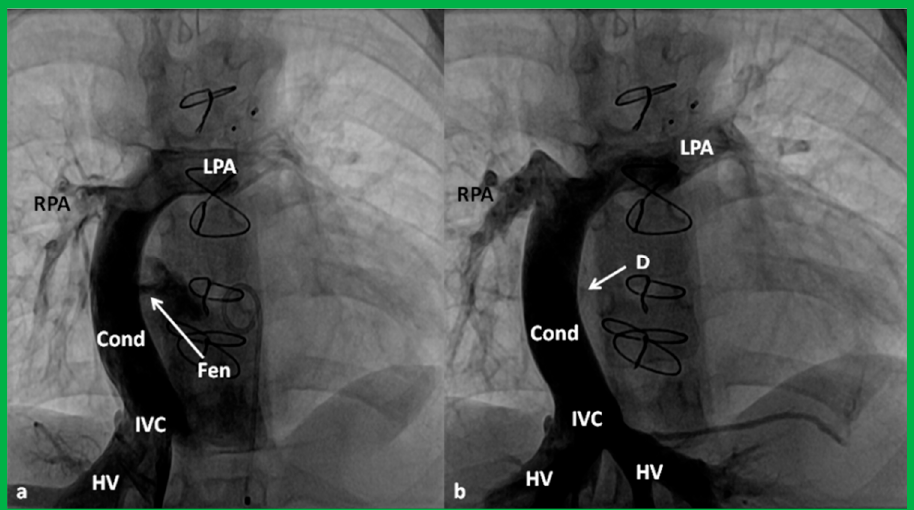
Figure 11. Cineangiographic images in the posteroanterior projection illustrating Stage IIIA of the Fontan operation transferring the blood from the inferior vena cava (IVC) into the pulmonary arter- ies via a non-valved conduit (Cond). The fenestration (Fen) is pointed out with an arrow in ( a ). The fenestration is occluded with an Amplatzer device (D), again, pointed out with an arrow in ( b ) (Stage IIIB). The hepatic vein (HV), left pulmonary artery (LPA), and right pulmonary artery (RPA) are marked. Reproduced from [63].